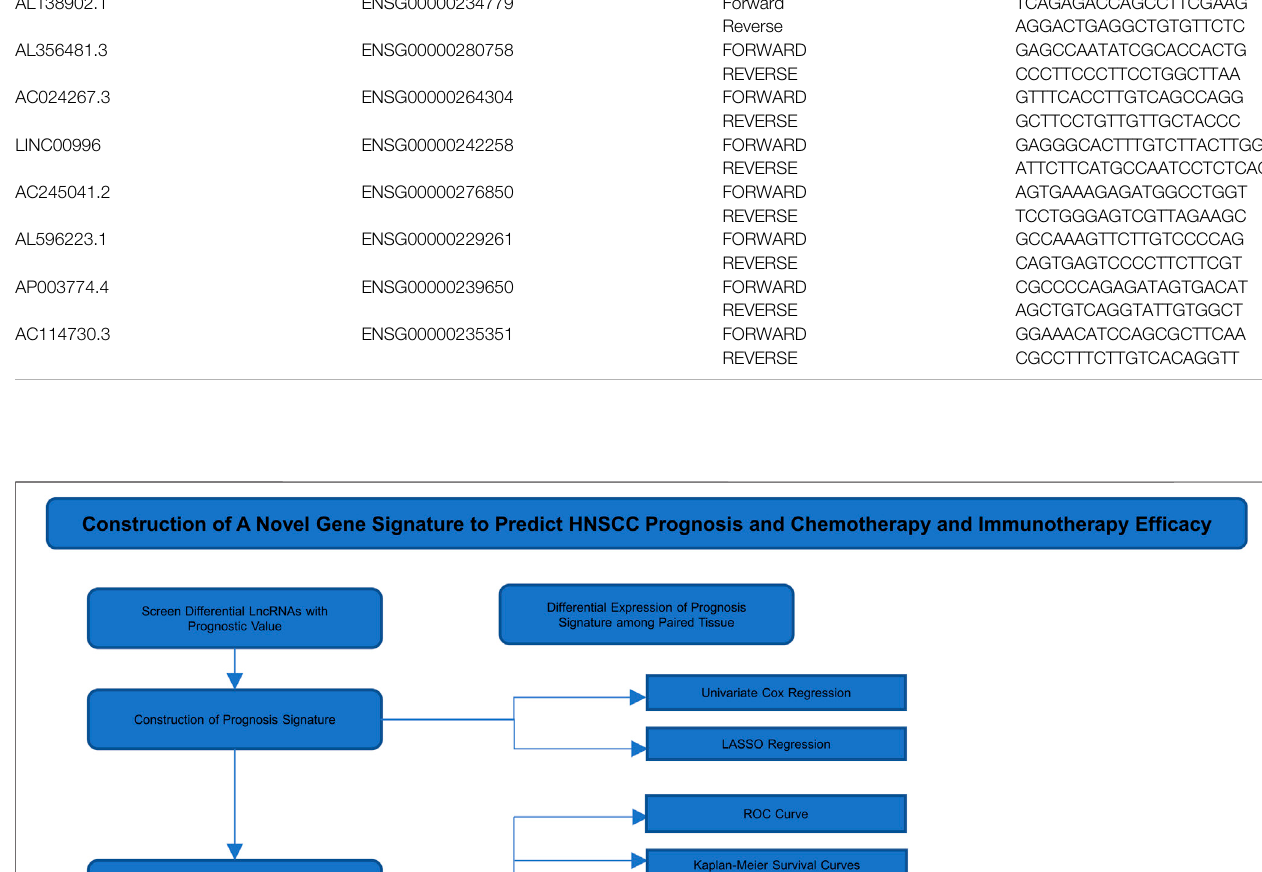
TABLE 1 | Primers of LncRNAs in prognosis signature. AL138902.1